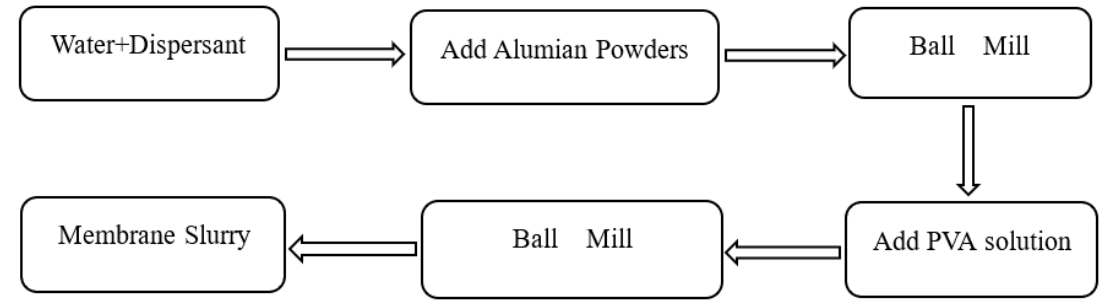
Figure 2. Preparation process of the ceramic membrane slurry.